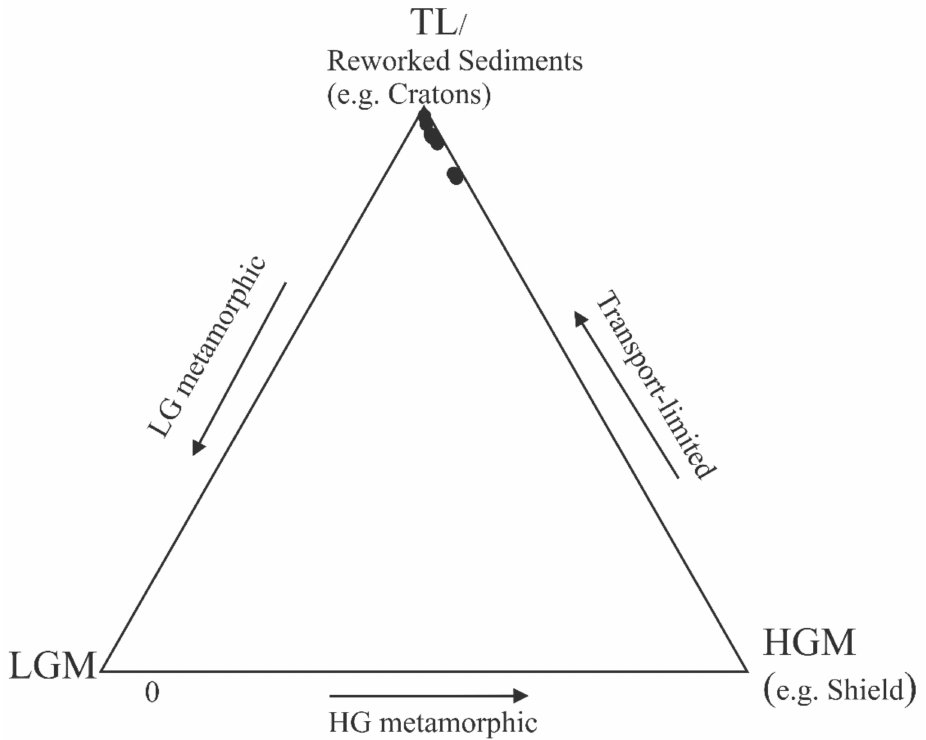
Figure 15. Tectonic setting discrimination TL-LGM-HGM heavy minerals plot indicating reworking of sediments in cratonic setting [97]. TL = transport limited; LGM = low grade metamorphic; HGM = high-grade